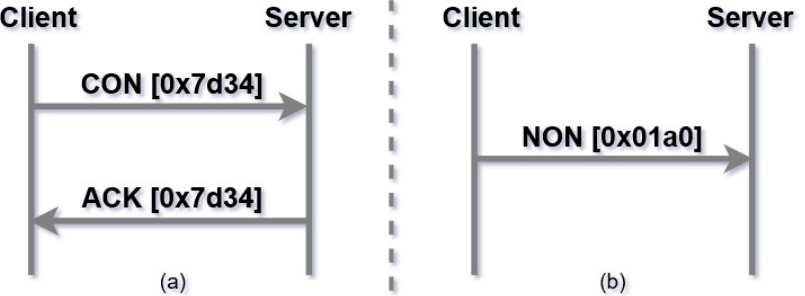
Figure 2. Messages types exchanged in CoAP: ( a ) Confirmable Messages; ( b ) Non-Confirmable Messages.